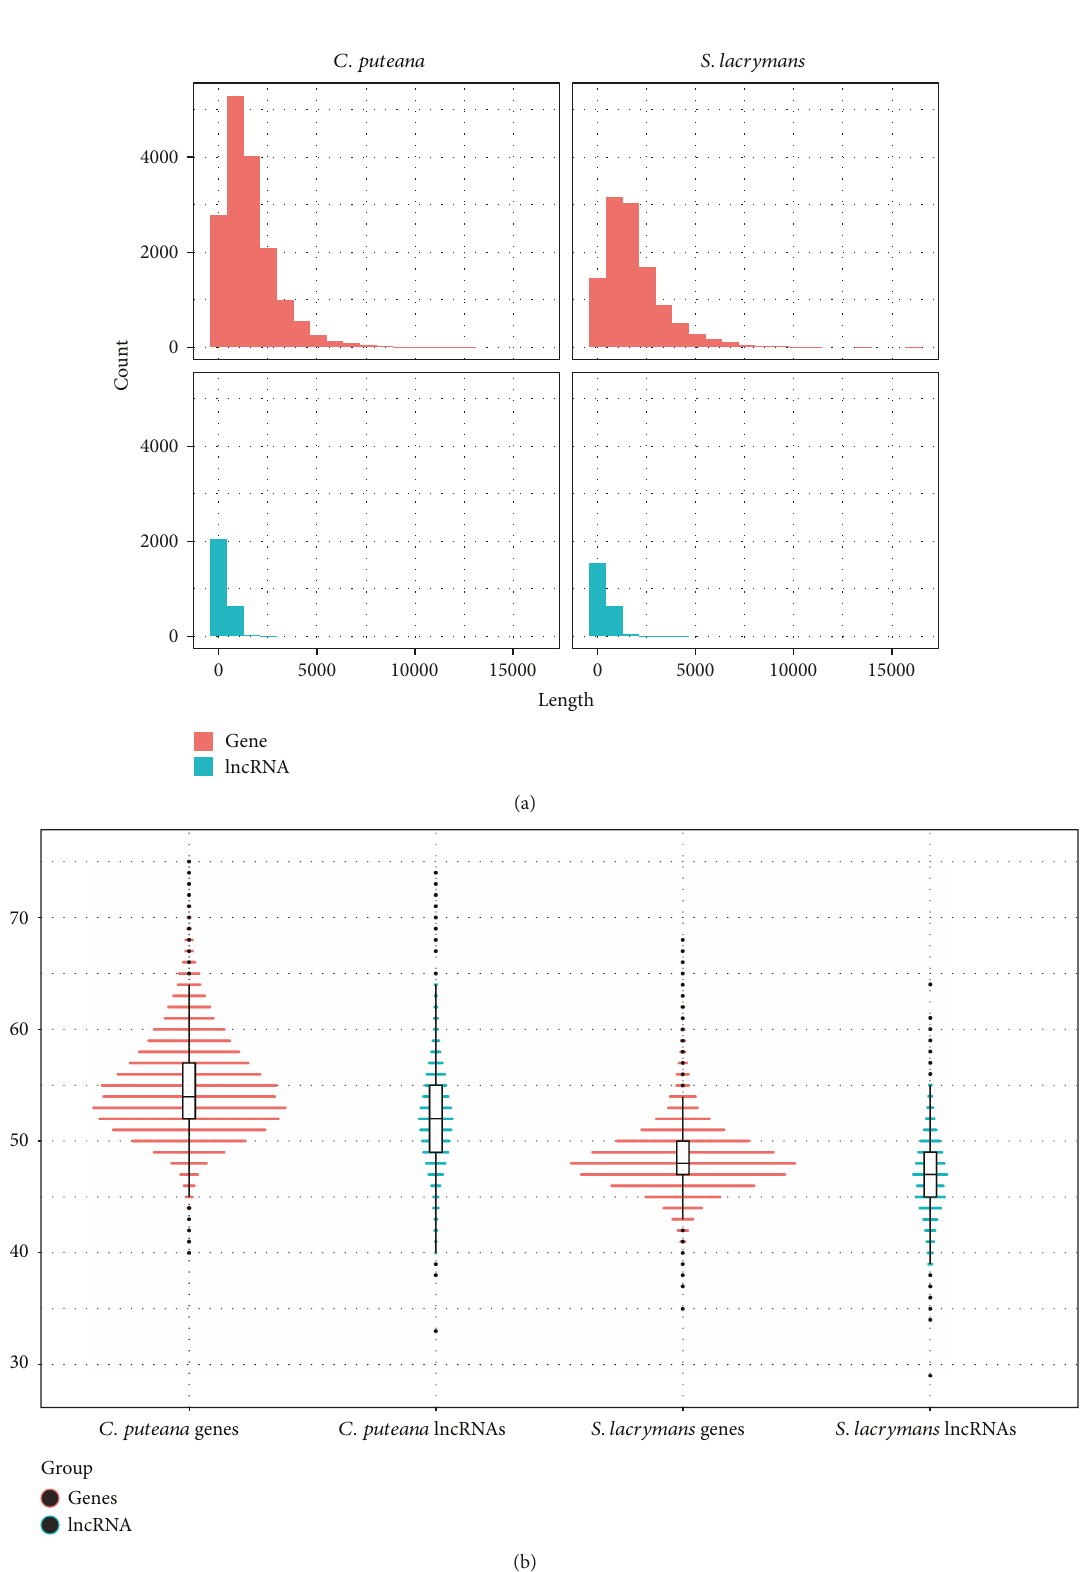
Figure 2: Distribution of length (a) and percentage of GC content (b) of coding isoforms and lncRNAs in C. puteana and S. lacrymans